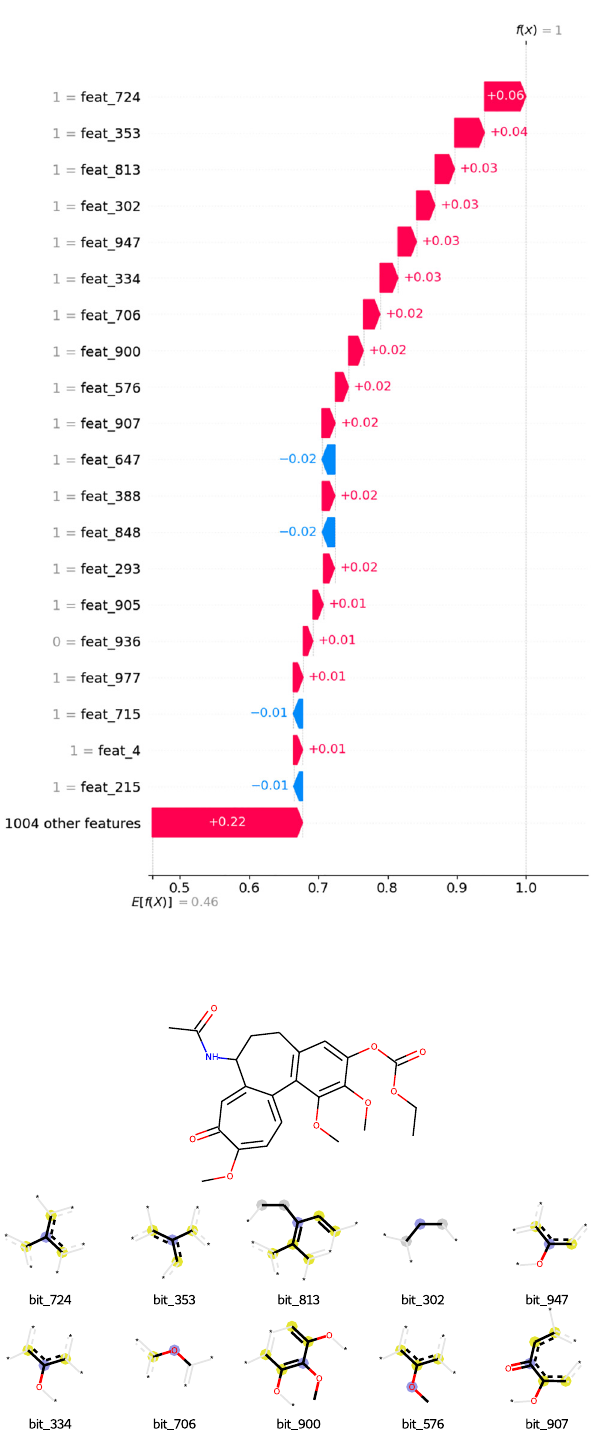
Figure 9: Molecular fragments corresponding to the ten ECFP4 bits that contribute the most towards the prediction for sample 537 from the NCI 1 test